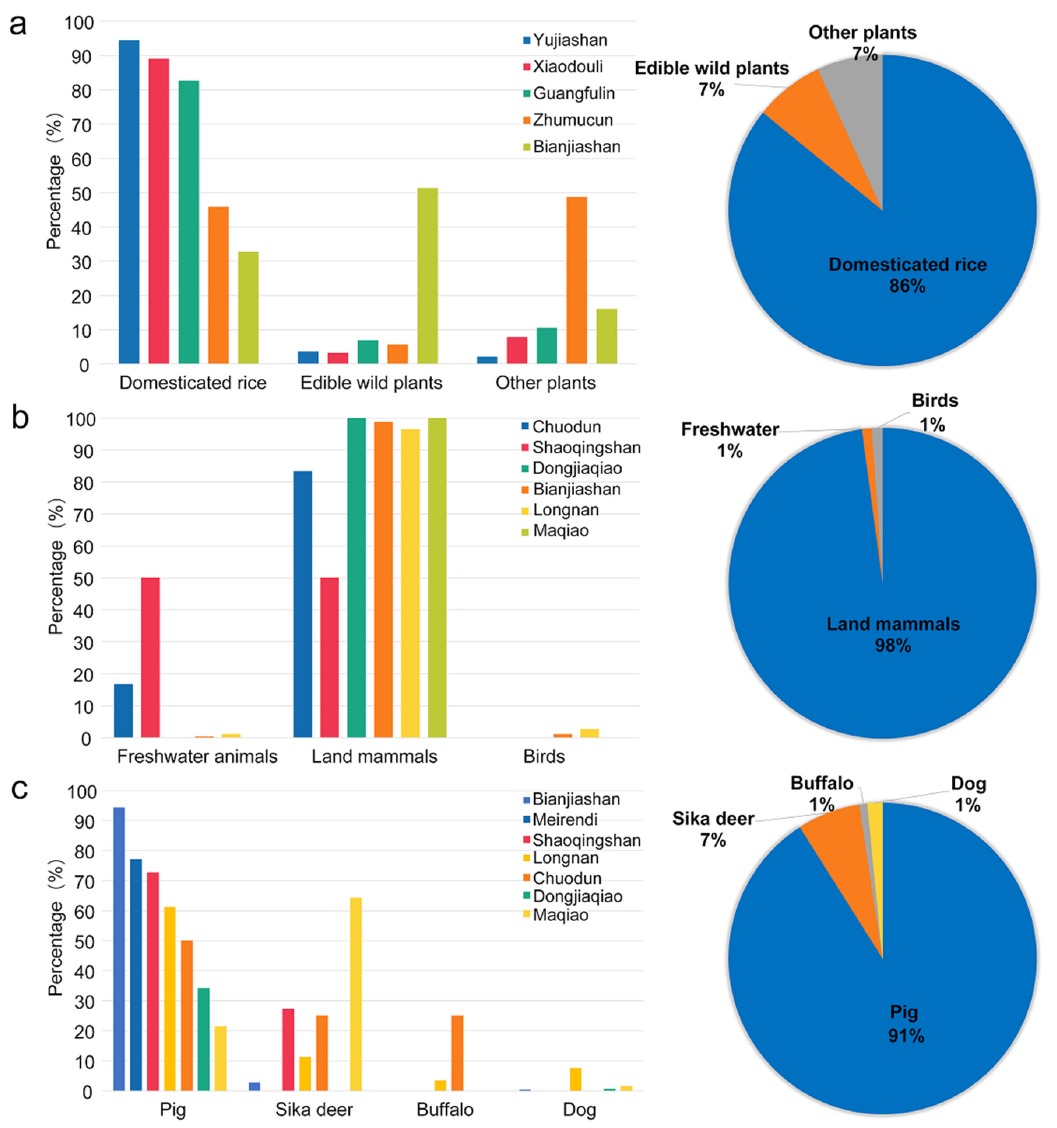
Figure 5. Comparison of different food resources during the Liangzhu Cultural period. Percentages ( left ) and relative proportions ( right ) of the three plant groups from the five sites ( a ); percentages ( left ) and relative proportions ( right ) derived from the NISP data of the three animal groups from the six sites ( b ); percentages ( left ) and relative proportions ( right ) derived from the NISP data of pig, dog, sika deer, and buffalo from the seven sites ( c